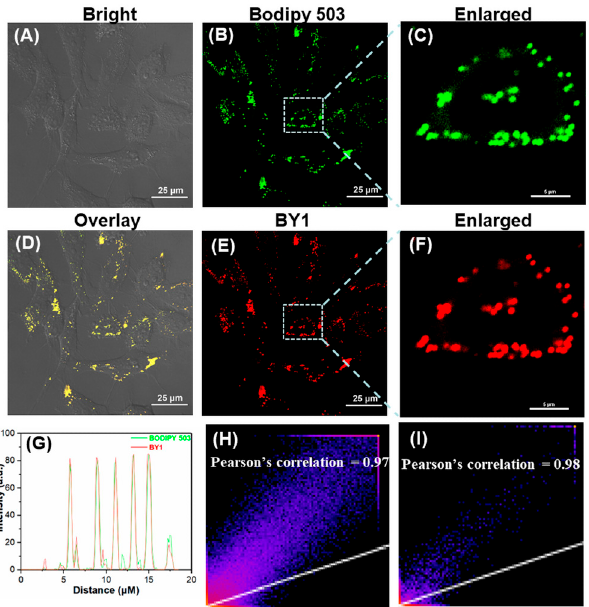
Figure 6. Cell imaging and co-localization imaging after incubation with BY1 (10 μ M) and Bodipy 503 (10 μ M) at 37 ℃ for 30 min. ( A ) Bright-field images. ( B , C ) Cell images of Bodipy 503 with green channel ( λ ex = 488 nm; λ em = 500–540 nm). ( D ) The overlay images. ( E , F ) Cell images of BY1 with red channel ( λ ex = 464 nm; λ em = 698 nm). ( G ) The intensity profile of ROI lines. ( H ) Two-dimensional intensity histogram of B and E. ( I ) Two-dimensional intensity histogram of C and F. Scale bar of A, B, D and E = 25 μ m, Scale bar of C and F = 5 μ m.